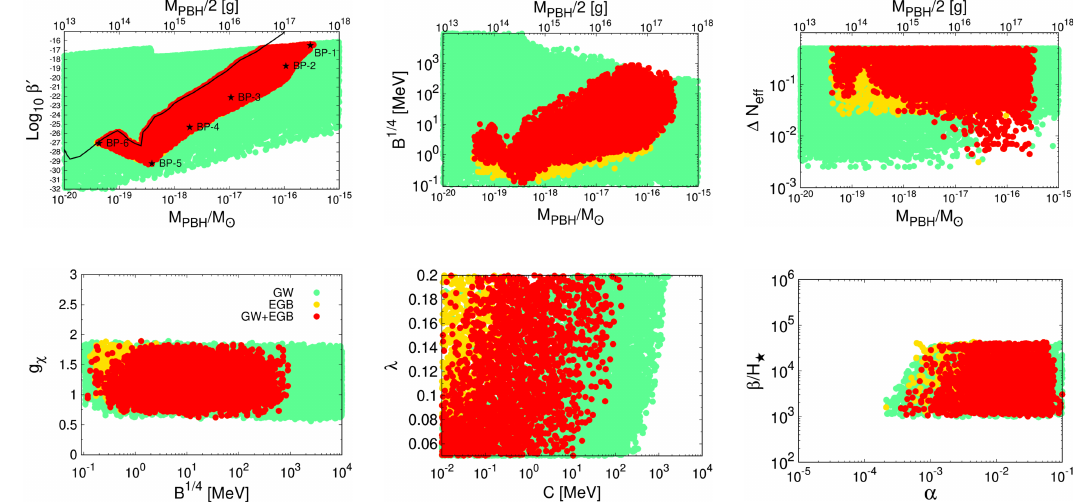
Figure 2 . The regions of parameter space that produce a detectable diffuse extragalactic X- ray/ γ -ray background at the MeV γ -ray telescopes, AMEGO-X/e-ASTROGAM (yellow), and a gravitational wave signal at THEIA/ µ Ares (green). In the red regions both measurements can be made. The solid black curve in the top left panel is the current bound from observations of the extragalactic γ -ray background and from the damping of small scale CMB anisotropies. All points satisfy Ω PBH h 2 ≤ 0 . 12 and ∆ N eff ≤ 0 . 5